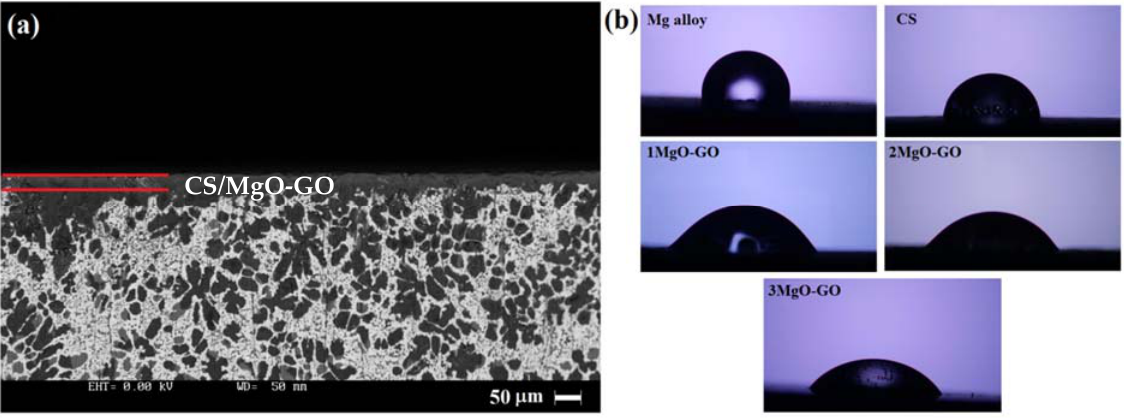
Figure 5. ( a ) Cross ‐ section SEM image, and ( b ) images of water contact angle of uncoated, CS, CS/1MgO ‐ GO, CS/2MgO ‐ GO, and CS/3MgO ‐ GO coated Mg alloys.